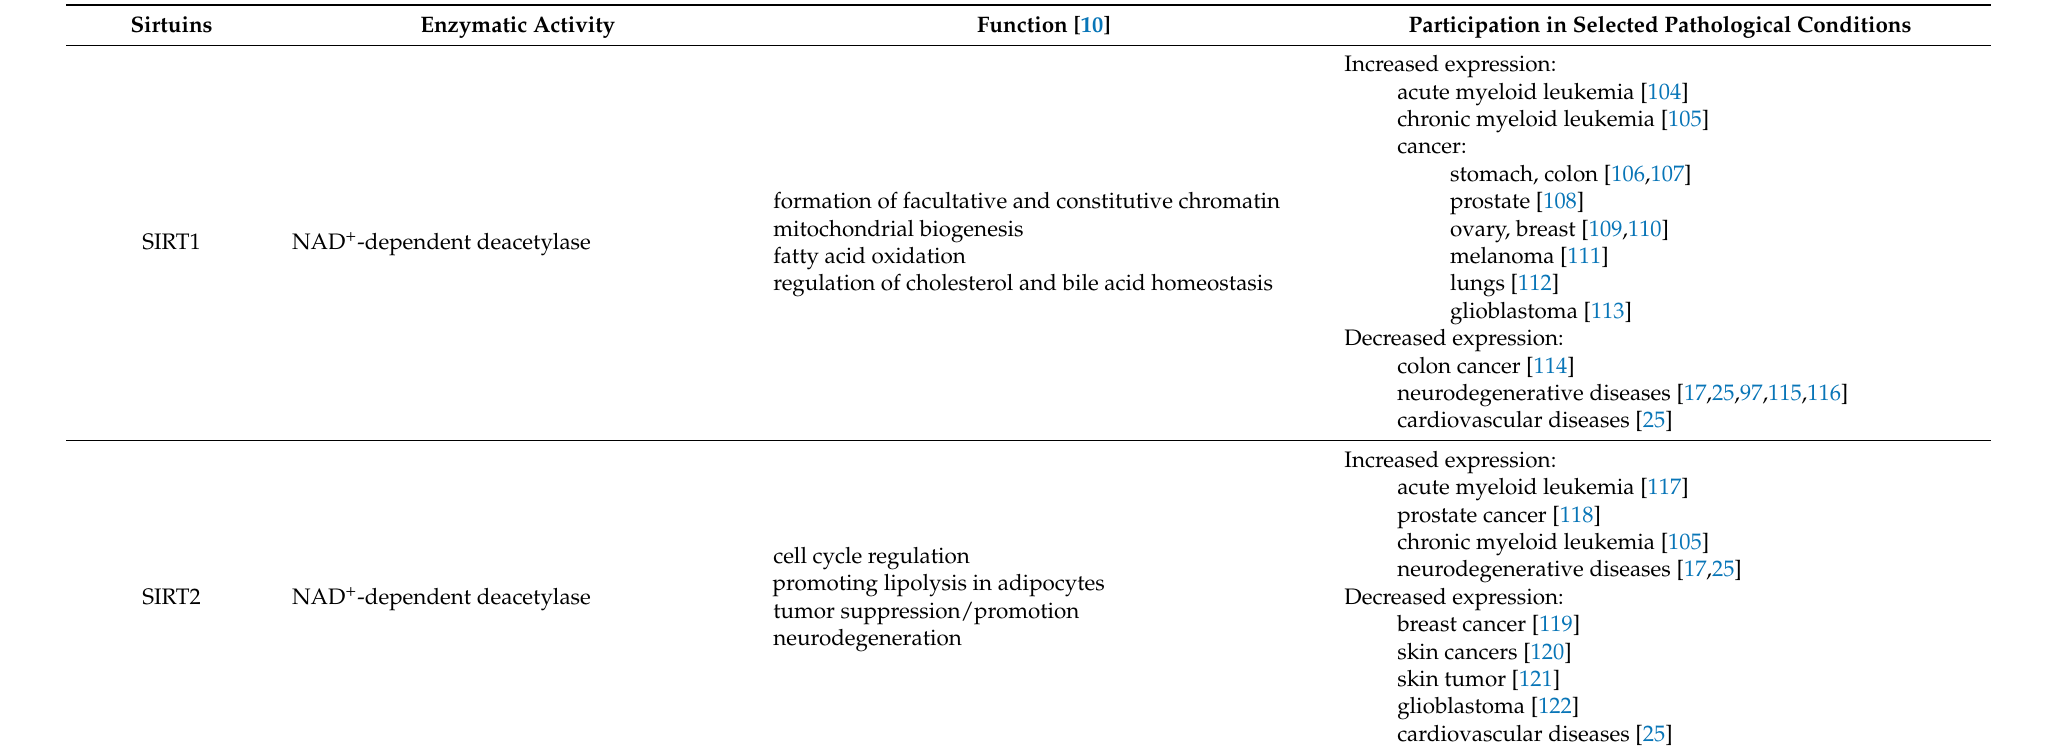
Table 2. Participation of SIRTs in selected pathological disorders.